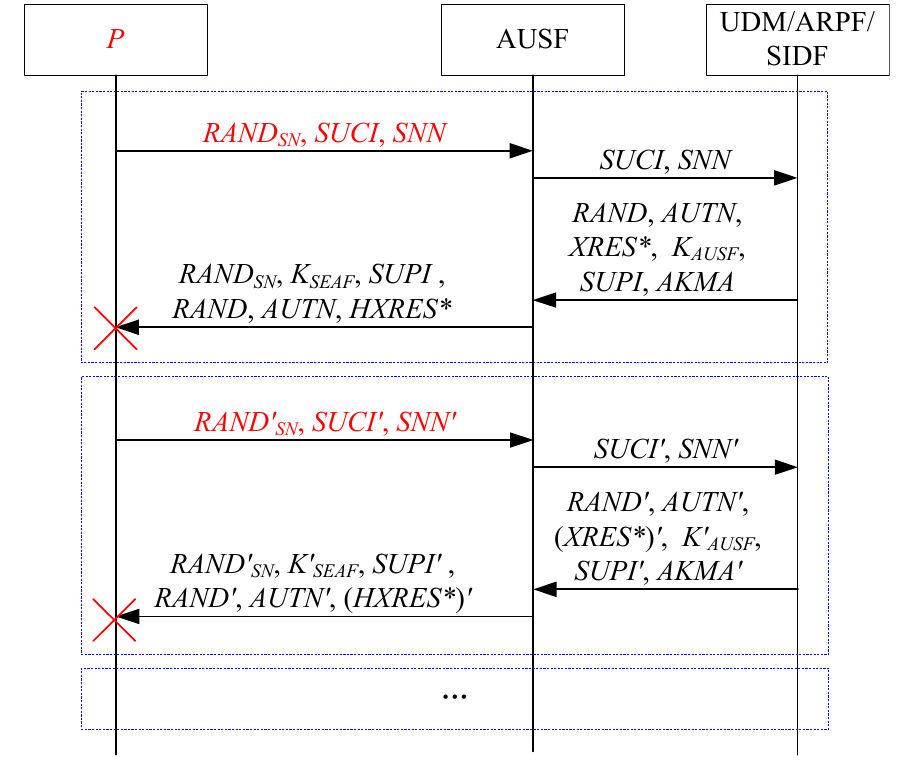
Figure 4. DoS attacks against the HN for the 5G-IPAKA protocol.